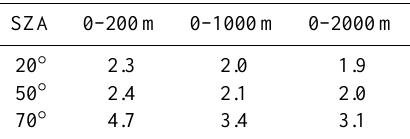
Table 1. The factor by which the retrieved tropospheric NO 2 VCD has to be corrected, depending on the height of the NO 2 profile and the solar zenith angle. Results are for cloud-free situations and an aerosol optical depth of